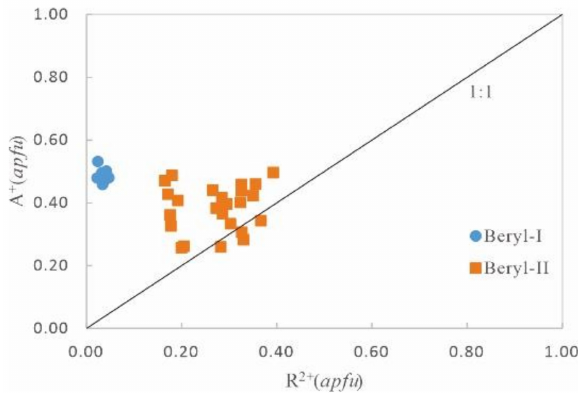
Figure 8. Plot of R 2+ versus A + . R 2+ represents divalent cations in the Y (octahedral) site, including Fe, Mg; A + represents monovalent alkali cations in the channel, including Na, Cs.